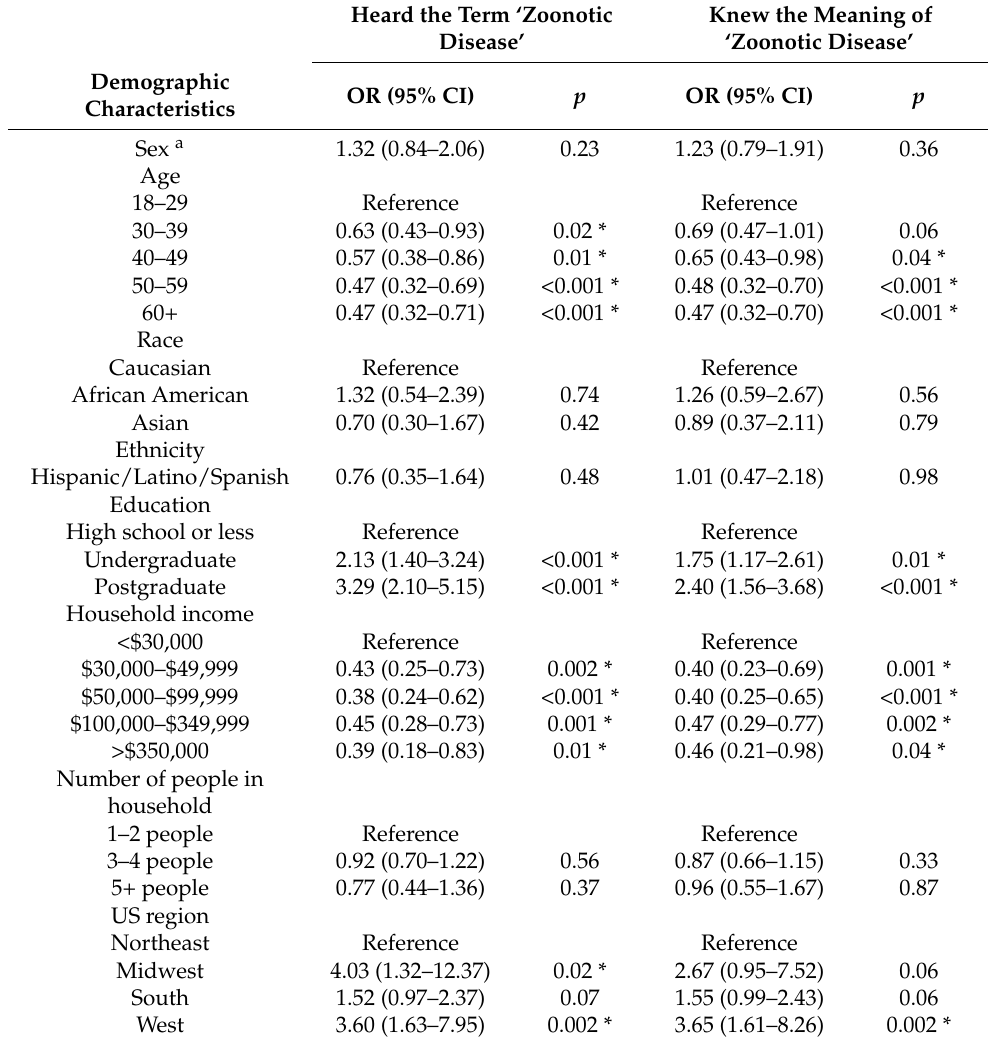
Table 2. Logistic regression models showing the associations between demographic characteristics and awareness of zoonotic